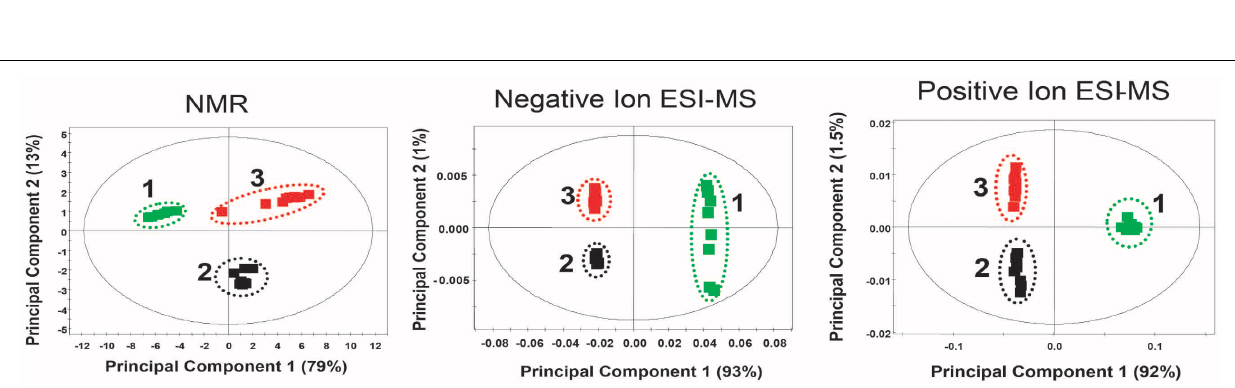
for the two short regions indicated by rectangles, which share 85% and 78% nucleotide sequence identity with T. atroviride scaffold 19. (B) Arrows indicating predicted protein-coding genes, which are described in Table 1 .